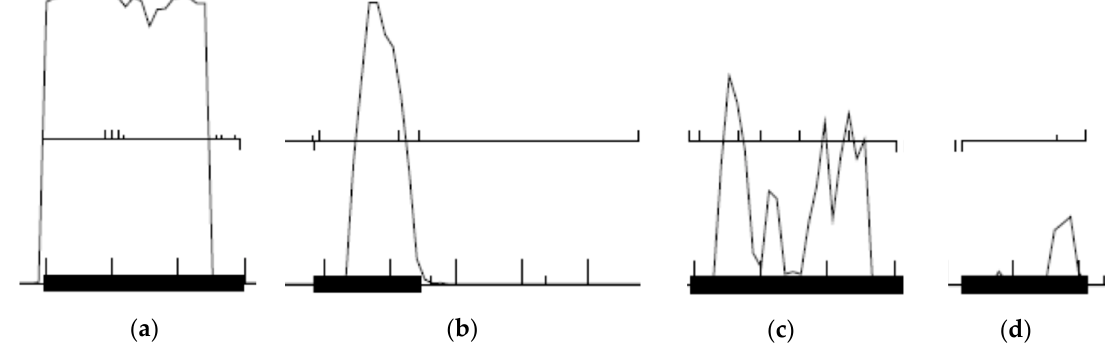
Figure 5. Examples of coding potential predicted by GeneMark S. Upward ticks represent start codons, downward ticks represent stop codons, and horizontal lines between ticks indicate ORFs. ( a ) The first putative gene on the left has high and sustained coding potential and is scored 3 points; ( b ) the second putative gene from the left has high but not sustained coding potential and is scored 2 points; ( c ) the third putative gene from the left has low but sustained coding potential and is scored 1 point; ( d ) the last putative gene on the right has coding potential that is low and not sustained and is thus scored 0 points.